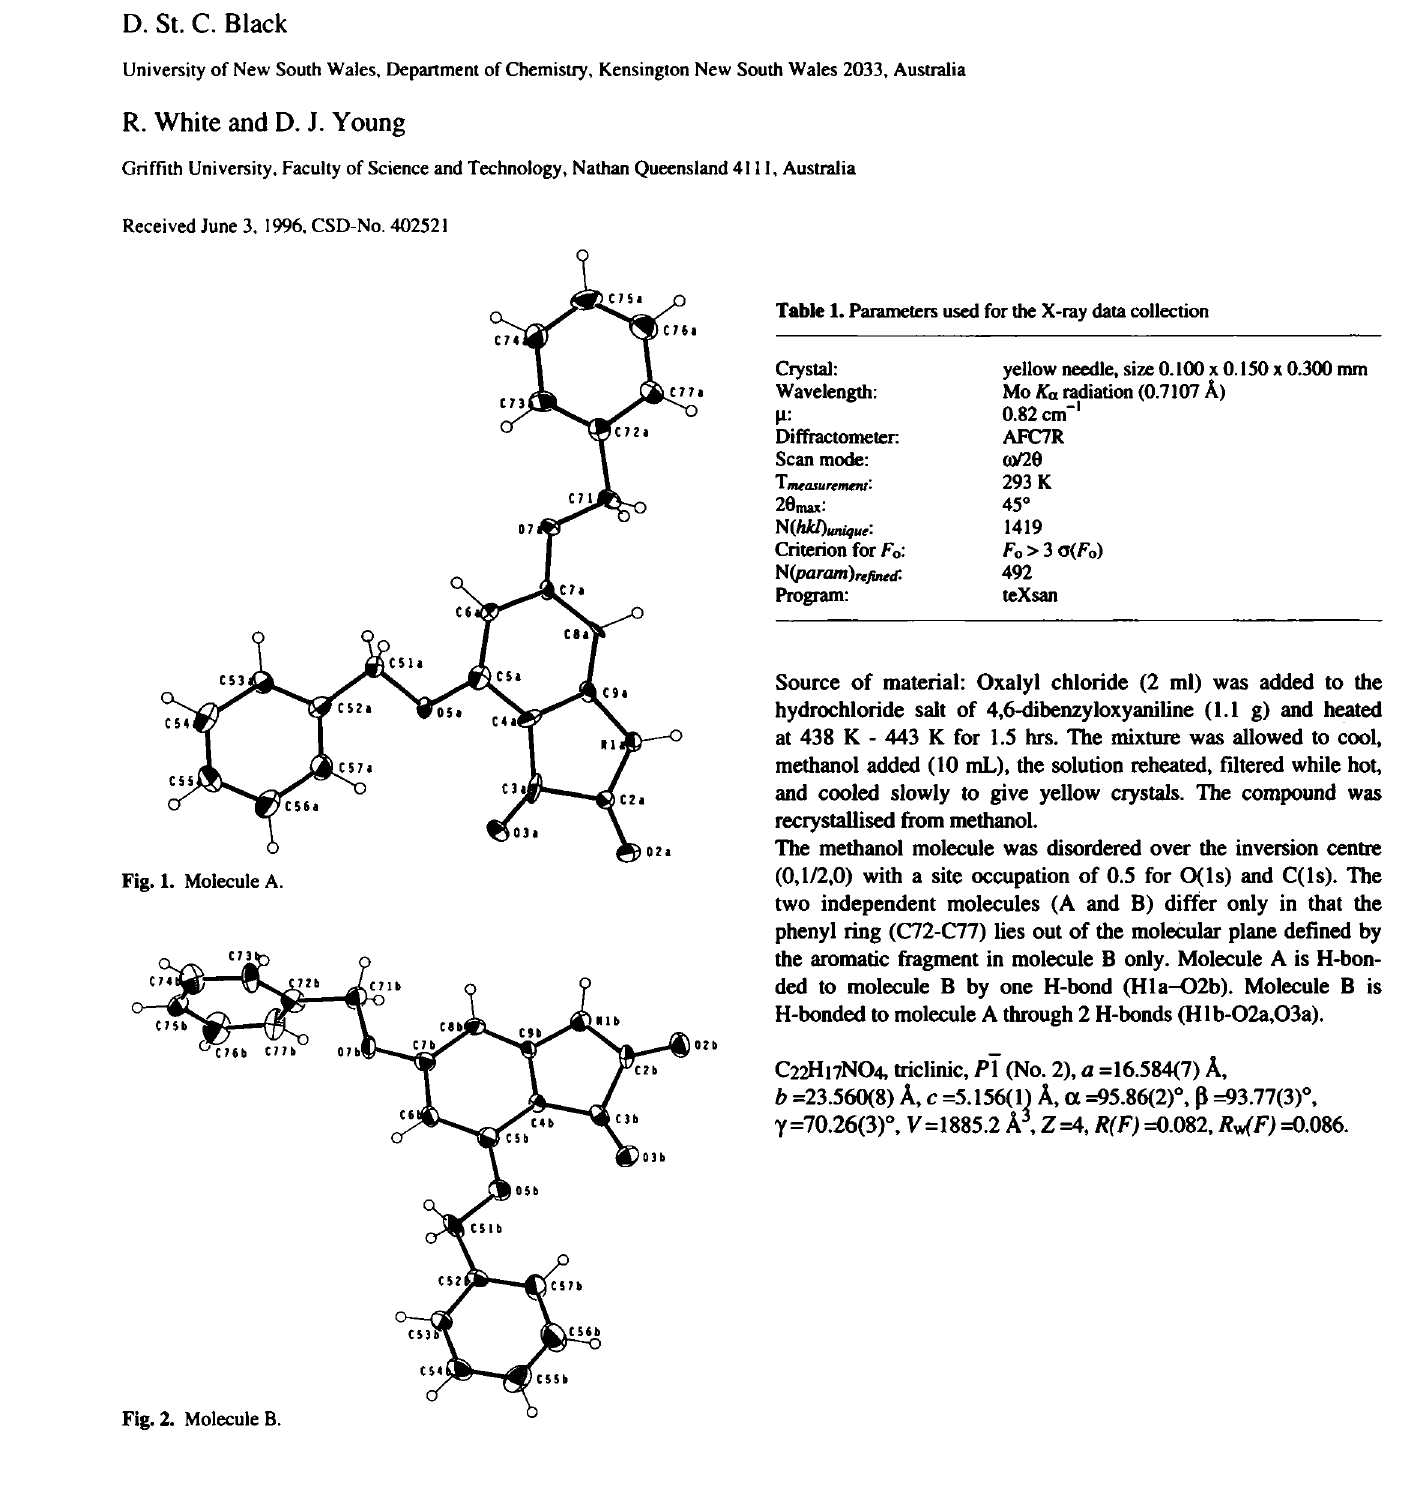
Table 1. Parameters used for the X-ray data collection Crystal: